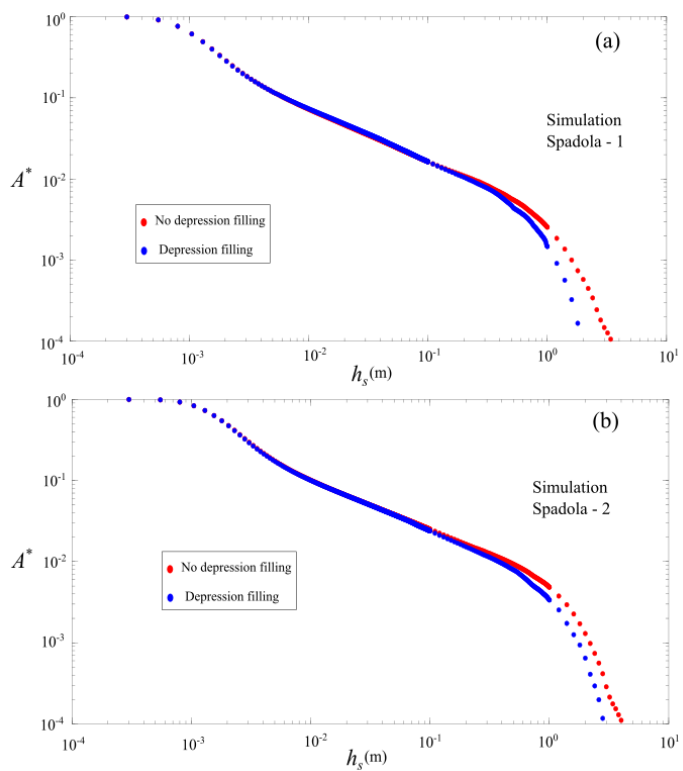
Figure 6. Spadola watershed. Effects of the DEM filling on the A *- h s curves: ( a ) Simulation Spadola-1 and ( b ) Simulation Spadola-2.